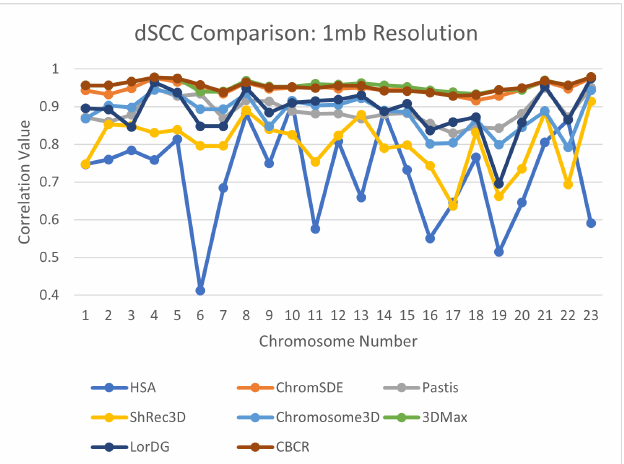
Figure 9. Comparison of dSCC between CBCR and 7 other methods on chromosomes 1–23 at 1 mb